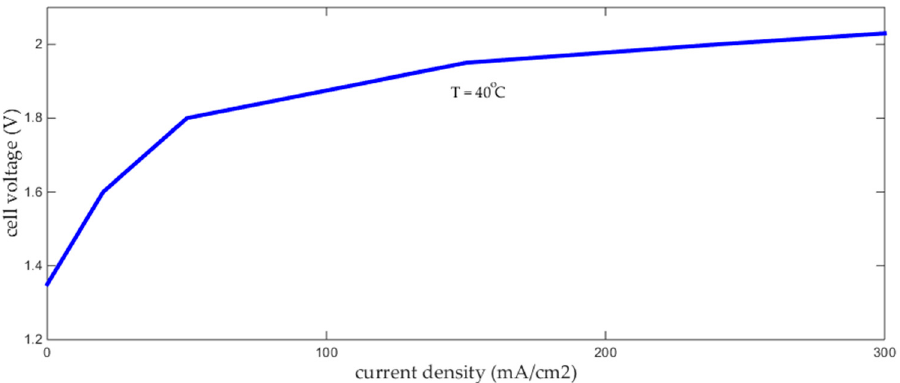
Figure 2. The V–I characteristic of the Proton ‐ Exchange Membrane (PEM) fuel cell at normal environmental conditions.